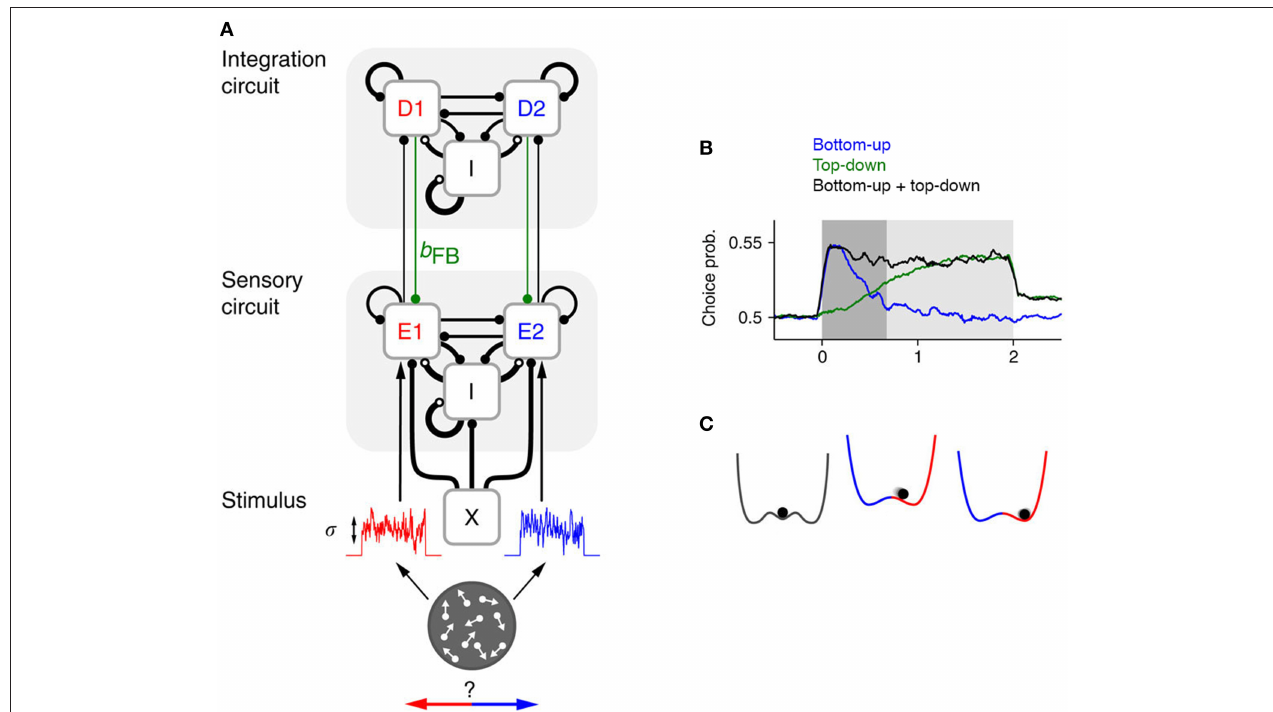
FIGURE 1 | (A) Graphical representation of the hierarchical network model constructed by Wimmer et al. (2015), which contains a layer of sensory neurons (with red and blue denoting populations selective for choice “left” and “right”, respectively) and a layer of integrator or decision neurons. The strength of the feedback from decision to sensory regions (in green), which is mediated by fast AMPA receptors in the model, can be systematically varied to assess the effect of top-down signals on choice probability and behavior. (B) A combination of early bottom-up and late top-down influences leads to a sustained choice probability signal, as observed in neural recordings. (C) Commitment to a choice corresponds to a well in the energy-landscape of the decision process. A well represents a stable state, which is maintained unless a lot of additional input is added to a system to shift it out of that state. All panels are adapted from Wimmer et al. (2015) under a CC-BY license.